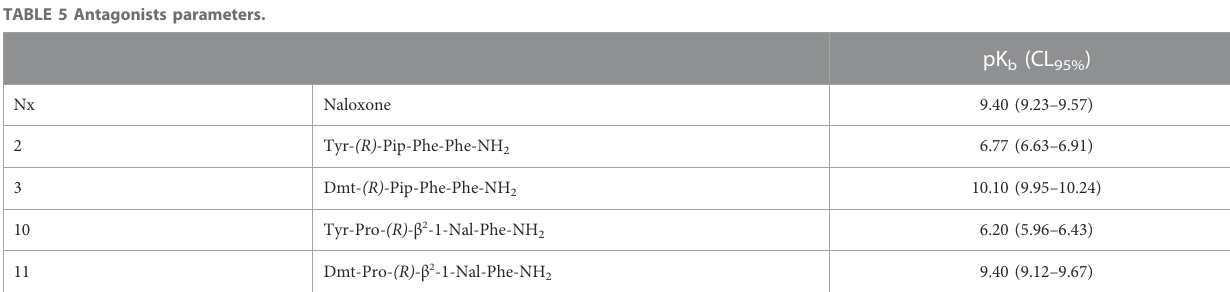
TABLE 5 Antagonists